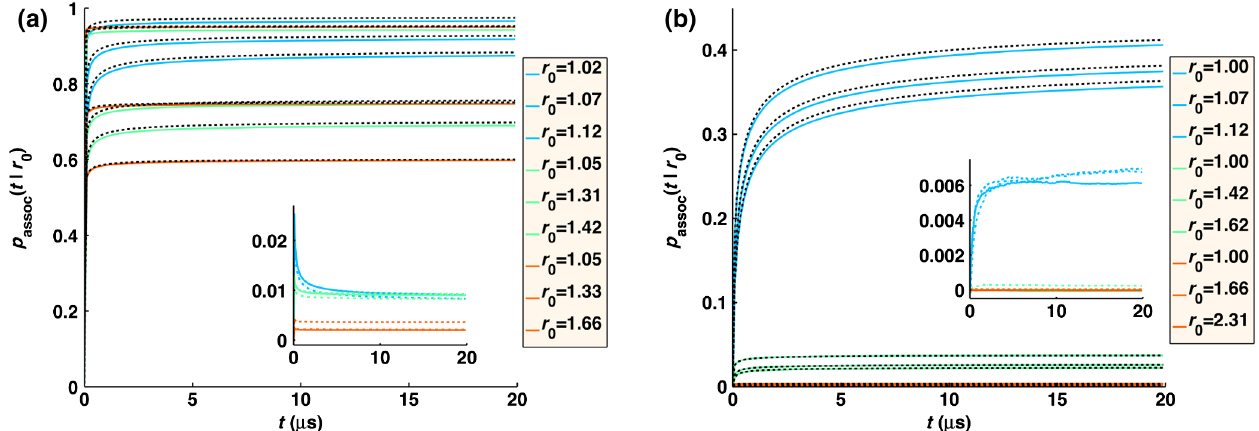
FIG. 5. Time-dependent probability of association of particle pairs. (a) Same parameters as Fig. 1, but now with the time step Δ t ¼ 0 . 001 μ s. For this smaller time step, the error increased, particularly for slower D AB . This is a result of incomplete sampling of the relevant trajectories and therefore incomplete reweighting of all trajectories. The error is larger for (a) k a ¼ ∞ , decreasing for the smaller association rate shown in (b) k a ¼ 10 nm 3 = μ s. The insets show the difference between exact and simulated